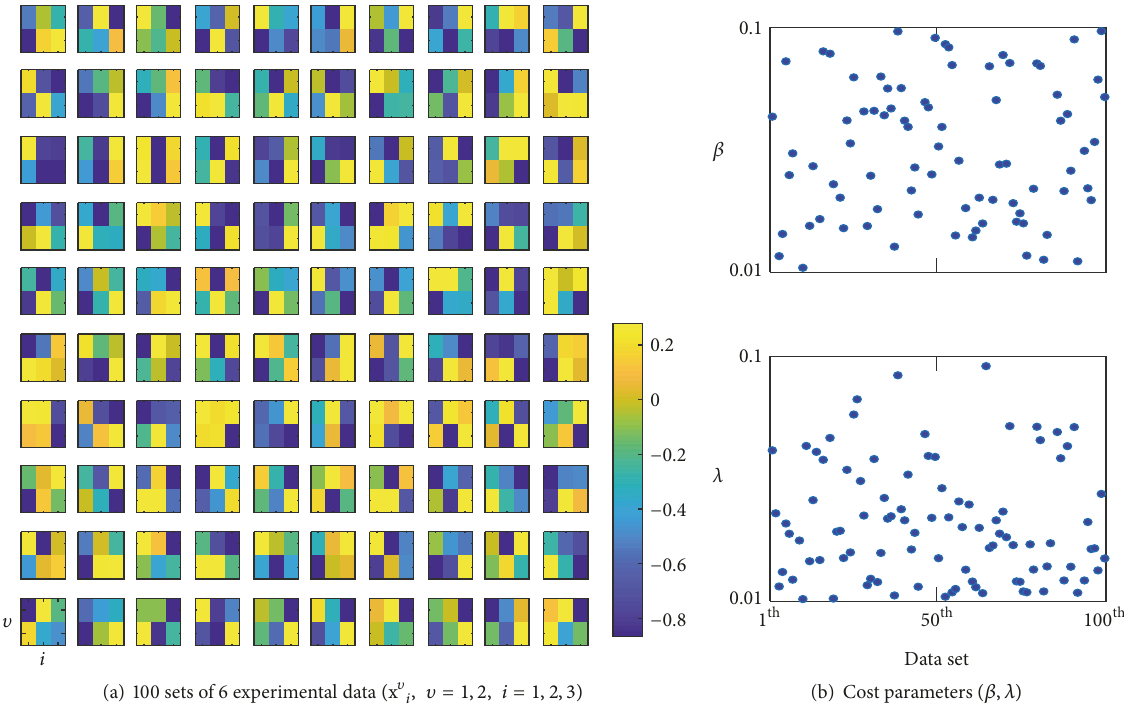
Figure 3: Experimental data and cost parameters. (a) Each of 100 color matrices denotes the values of 6 artificial experimental data 𝑥 𝜐 𝑖 (𝜐 = 1,2, 𝑖 = 1,2,3) . Values of the 𝑥 - and 𝑦 -axis in each color matrix denote the values of 𝑖 and 𝜐 , respectively, where the color in the entry (𝑖, 𝜐) denotes the value of 𝑥 𝜐 𝑖 . (b) A value on the 𝑥 -axis denotes an experimental data set in Figure 3(a). The data set at entry (𝑖, 𝑗) in Figure 3(a) is represented as the 10(𝑖 − 1) + 𝑗 𝑡ℎ data set in Figure 3(b). There are few values of 𝛽 and 𝜆 greater than 0.1 and we do not show them